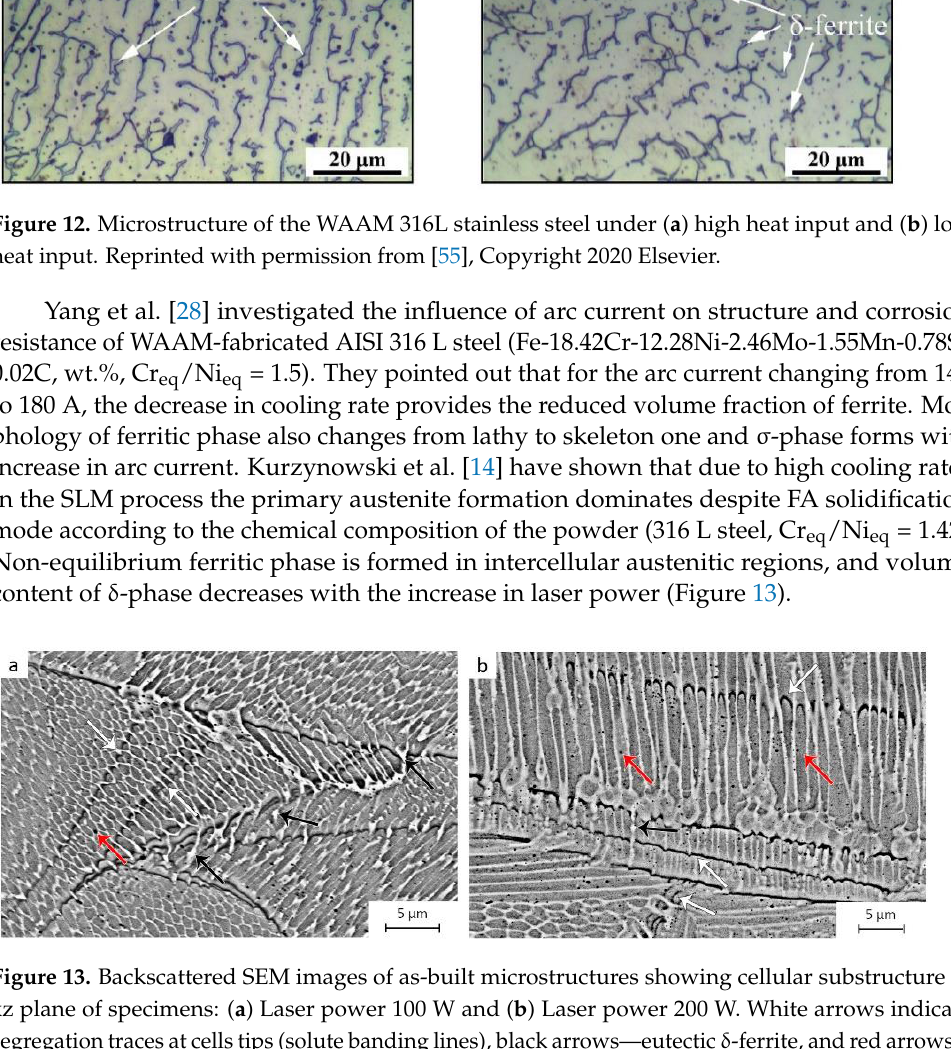
Table 4. Comparison of mechanical properties of some AM AISI 316L stainless steels. The compo- sitions are given in wt.%. Data are adapted from [14,21,26,60,64–66]. Method of Manufacture